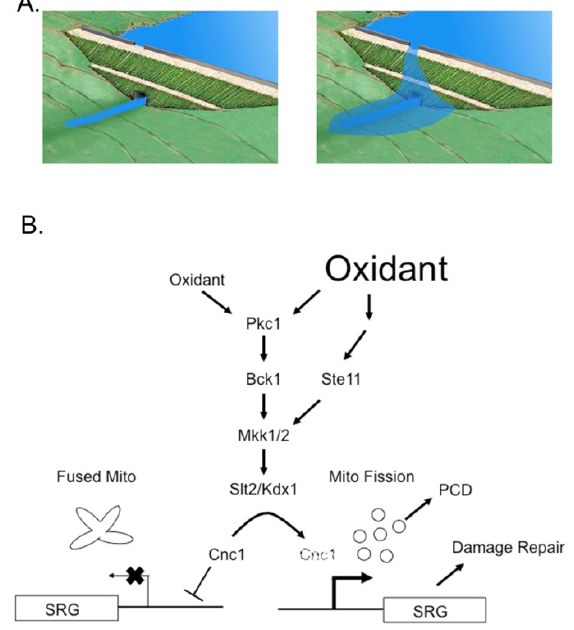
FIGURE 1: Differential signaling during oxidative stress via the cell wall integrity (CWI) pathway. (A) The top left panel shows a dam with a spillway at the top. Low water levels are retained behind the dam and the only outflow is via the dam outlet at its base. The top right panel shows the result when water levels crest the dam and flow over the spillway. This leads to a larger down- stream output. (B) Signaling under either low (left side) or high (right side) oxidative stress conditions through the CWI pathway is shown. Note that these signaling events lead to the eventual deg- radation of cyclin C (Cnc1) as indicated by the dashed text. When Cnc1 is present, stress-responsive genes (SRG) are repressed and mitochondria exhibit a multilobe, fused morphology. Activation of the CWI pathway triggers Cnc1 degradation with accompanying mitochondrial fission, SRG activation and either programmed cell death (PCD) or repair of the stress-induced damage. See the text for further